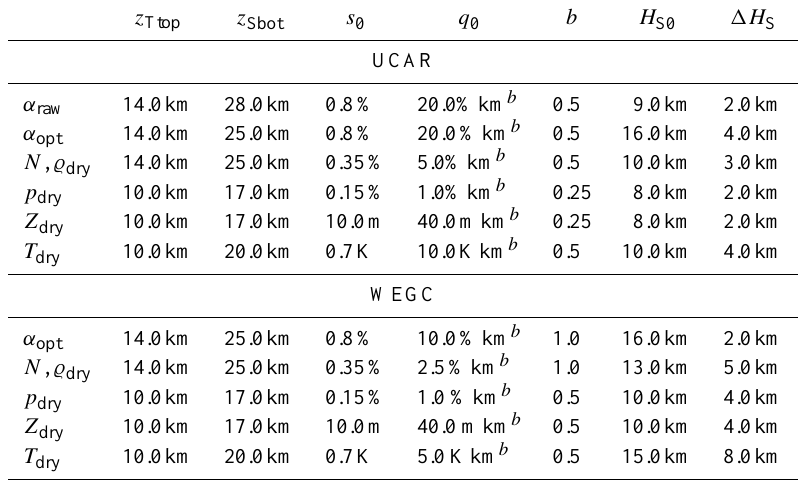
Table 1. UCAR and WEGC model parameter values for the simple analytical error model for different RO atmospheric parameters, appli- cable to UCAR α raw , α opt , and N up to 50km, to other UCAR and all WEGC atmospheric parameters up to 35km. Note that the unit of q 0 depends on the parameter b , which is given in the column to the right. z Ttop z Sbot s 0 q 0 b H S0 1H S UCAR α raw